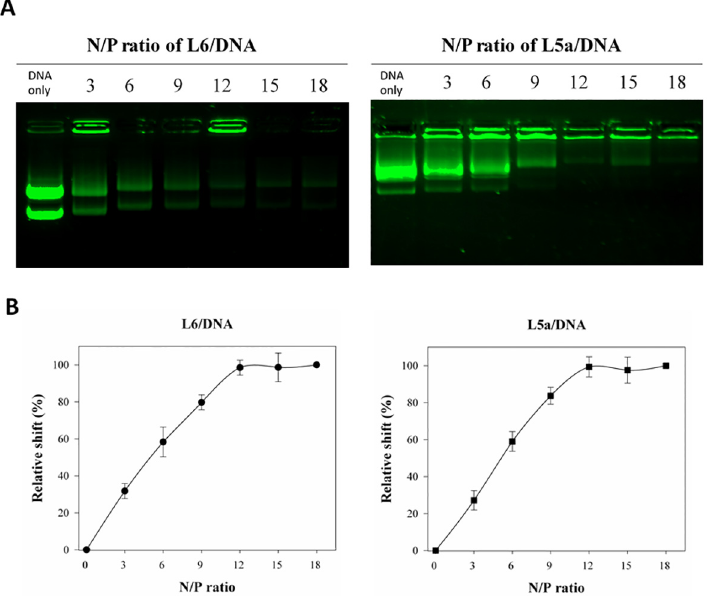
Fig 3. Noncovalent interactions between CPPs and plasmid DNA in vitro . (A) Gel retardation assay indicating the formation of CPP/DNA complexes. Various amounts of L6 or L5a were mixed with DNA at molecular N/P ratios of 0 (DNA only), 3, 6, 9, 12, 15, and 18. These complexes were analyzed by electrophoresis on a 0.5% agarose gel, followed by SYBR Safe staining. DNA images were captured using a ChemiDoc XRS+ Gel Imaging System (Bio-Rad). (B) The relative mobility of CPP/DNA complexes. The mobility of CPP/DNA complexes is indicated. Data are presented as mean ± SD from five independent experiments in each treatment